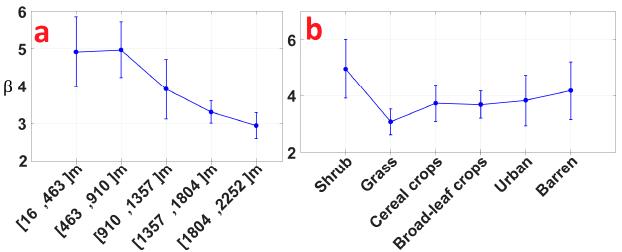
Figure 5. Mean and standard deviation of β values for weather stations with different ( a ) DEM classes, and ( b ) land covers.